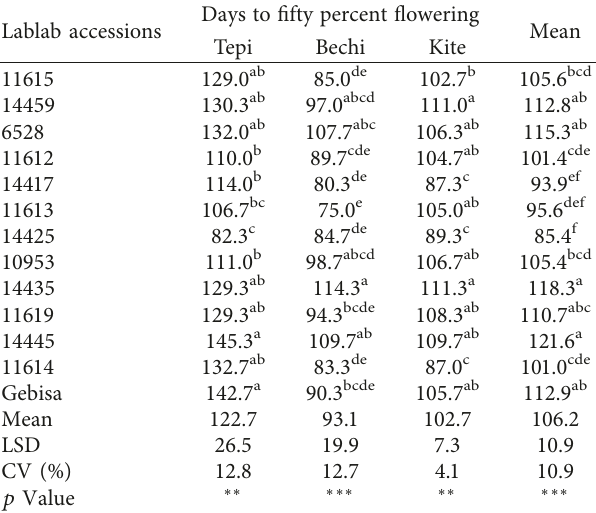
Table 4: Number of days to fifty percent flowering of lablab ac- cessions at Tepi, Bechi, and Kite testing sites. Lablab accessions